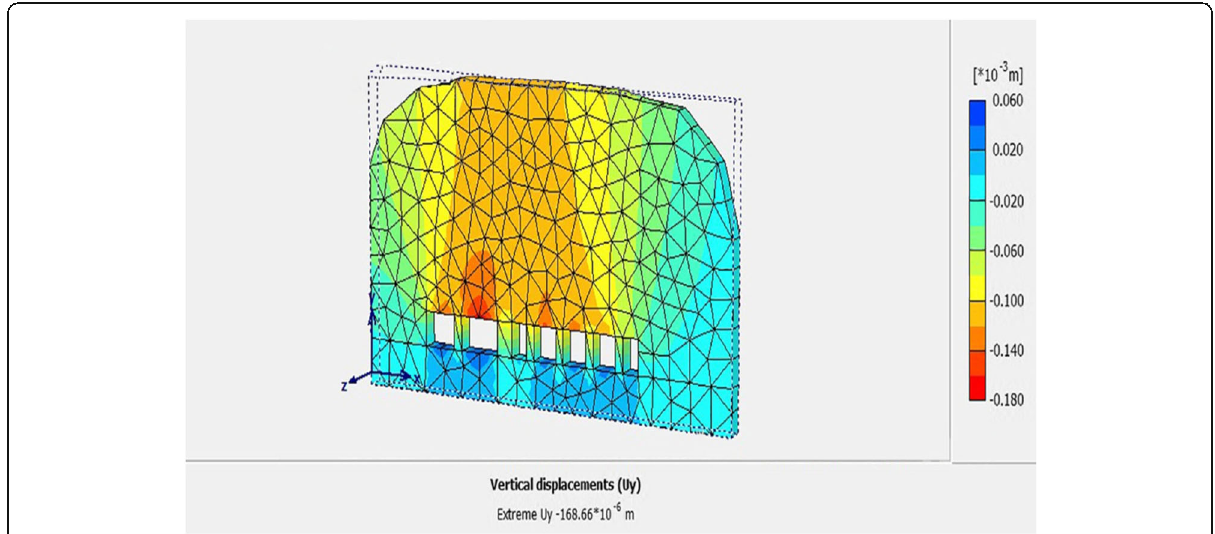
Fig. 22 Vertical displacements of the support rock pillars in Chamber 3. PLAXIS